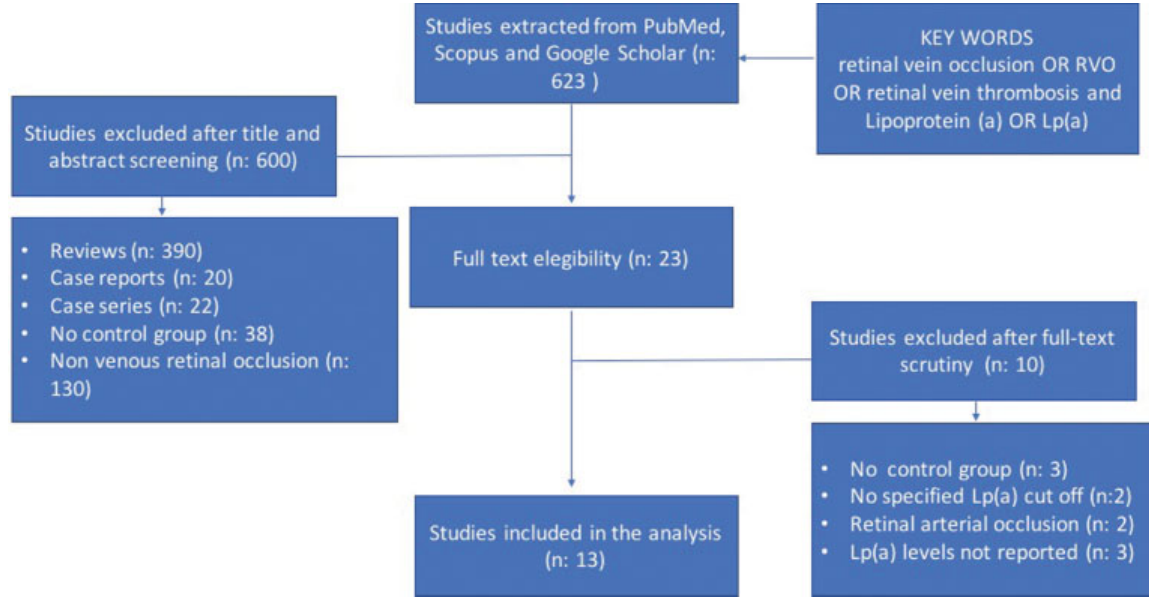
Fig. 1 Search strategy and study